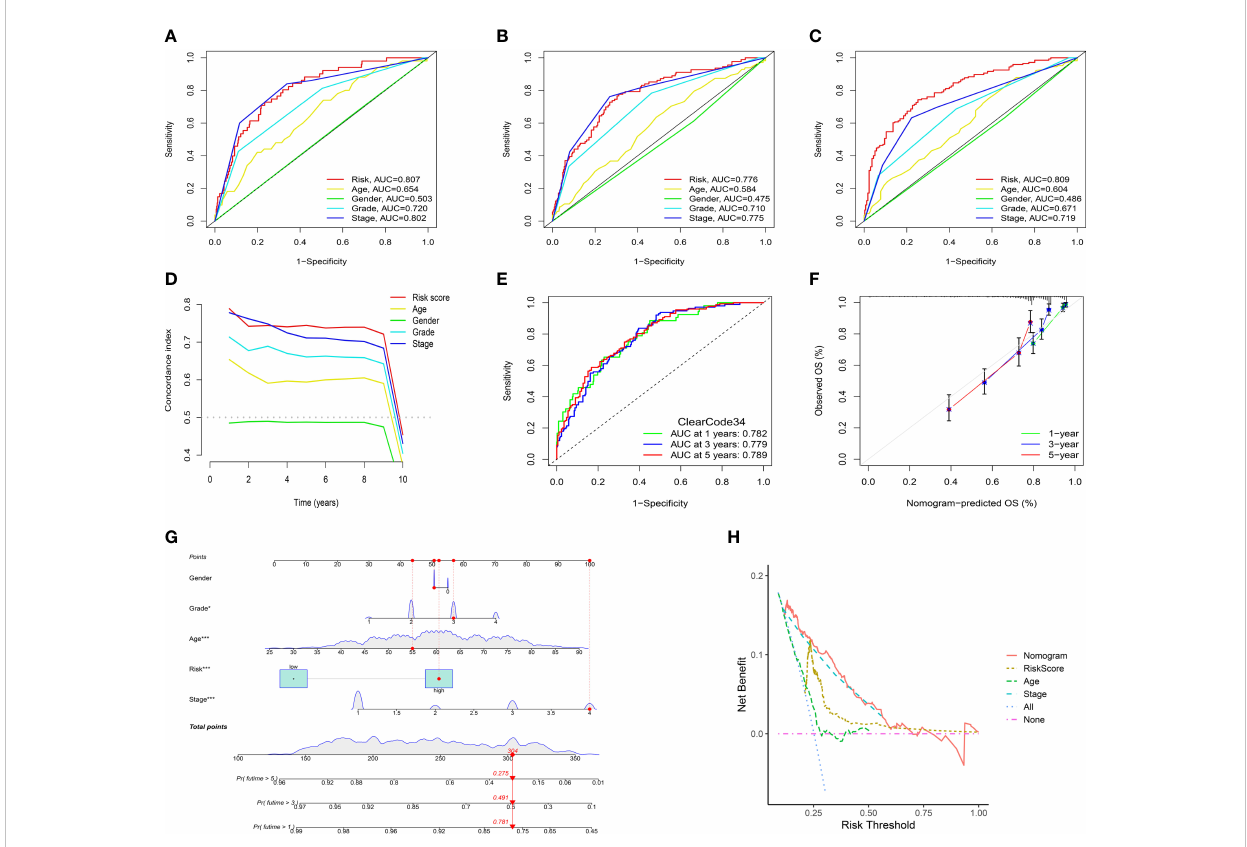
FIGURE 7 Assessment of the IRFs-related prognostic model and construction of a nomogram to predict the OS. (A-C) ROC curves of the nomogram in predicting the 1-,3- and 5-year OS in the TCGA-KIRC dataset. (D) C-indexes of the risk score and clinical characteristics. (E) ROC curves of the ClearCode34 model in predicting the 1-, 3- and 5-year OS. (F) The calibration curve of the nomogram in predicting the 1-, 3- and 5-year OS. (G) Construction of a nomogram based on age, gender, stage and risk score. (H) DCA curve of the nomogram. * p<0.05, *** p<0.001